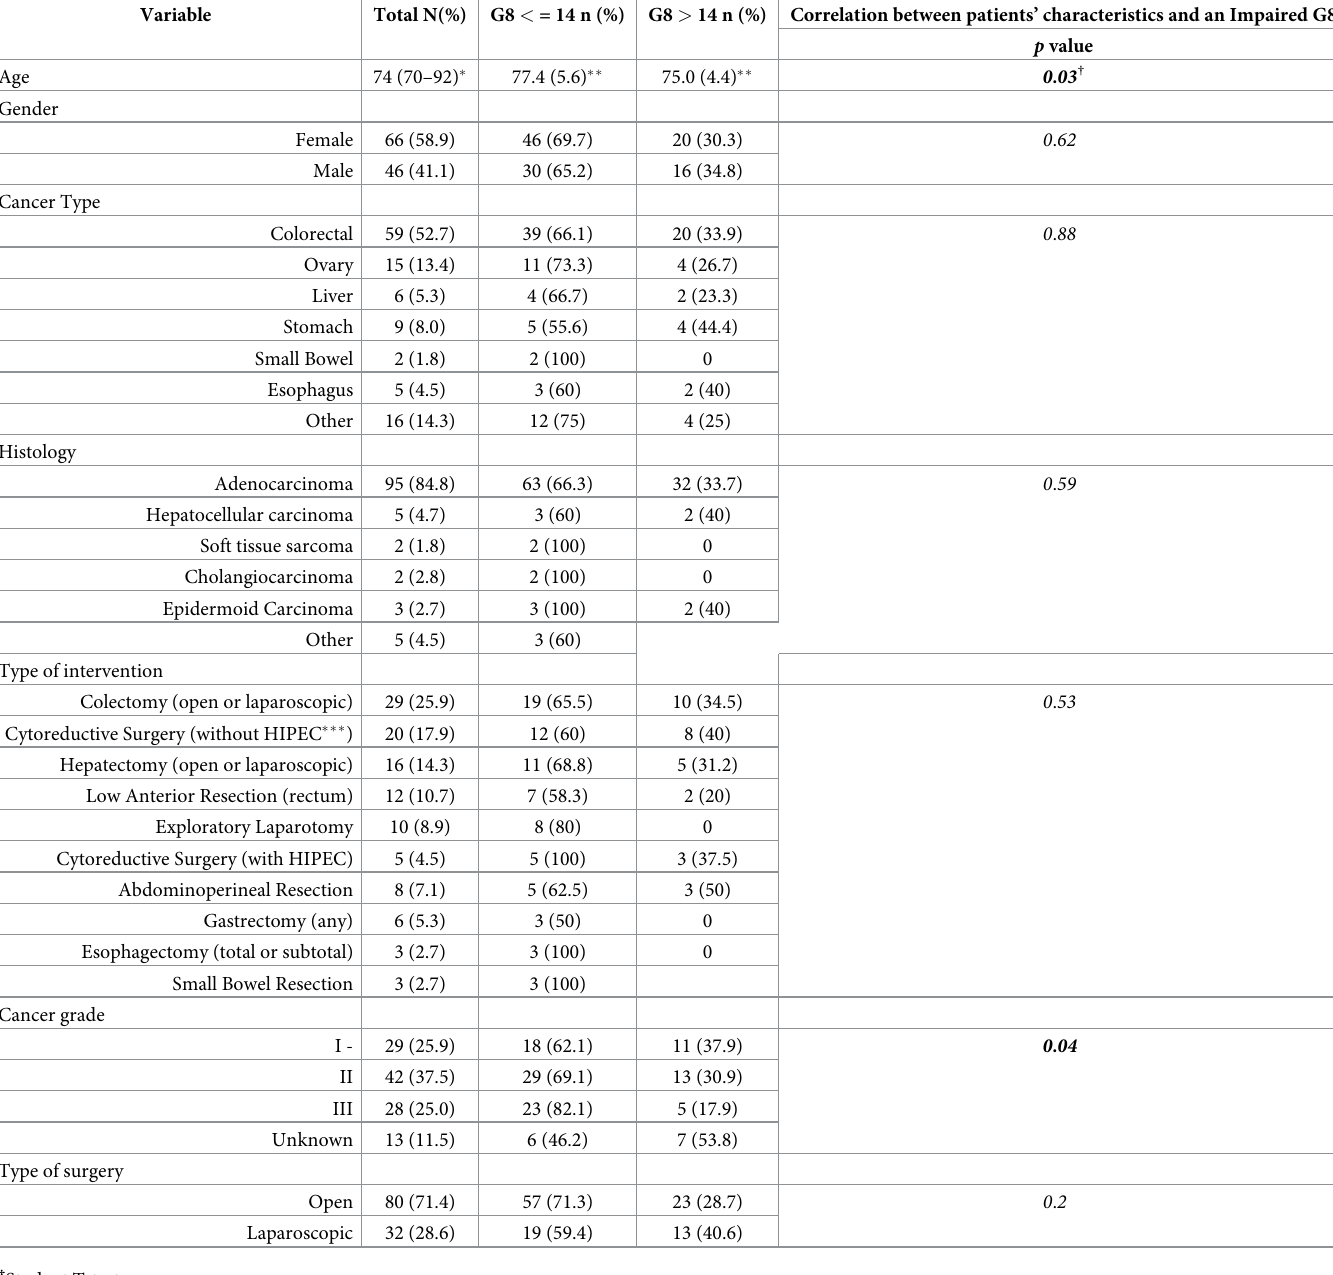
Table 1. Patients’ clinical and demographic characteristics, and their correlation with an impaired G8 with respect to each subgroup.